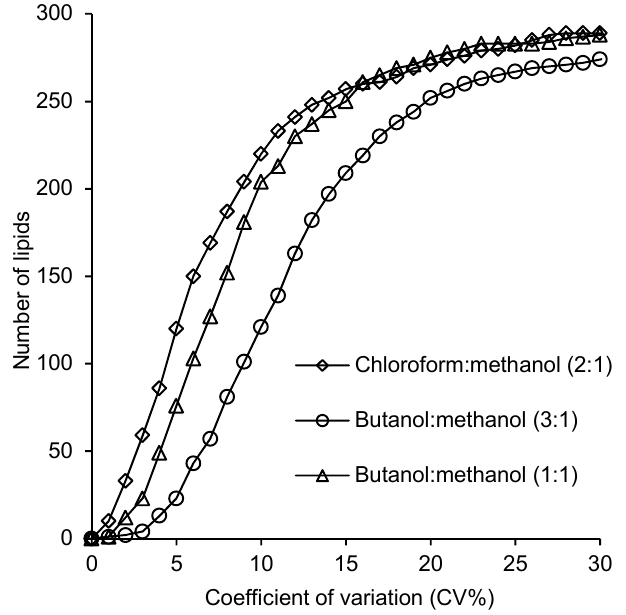
Figure 4. Within-batch coefficient of variation of the different extraction